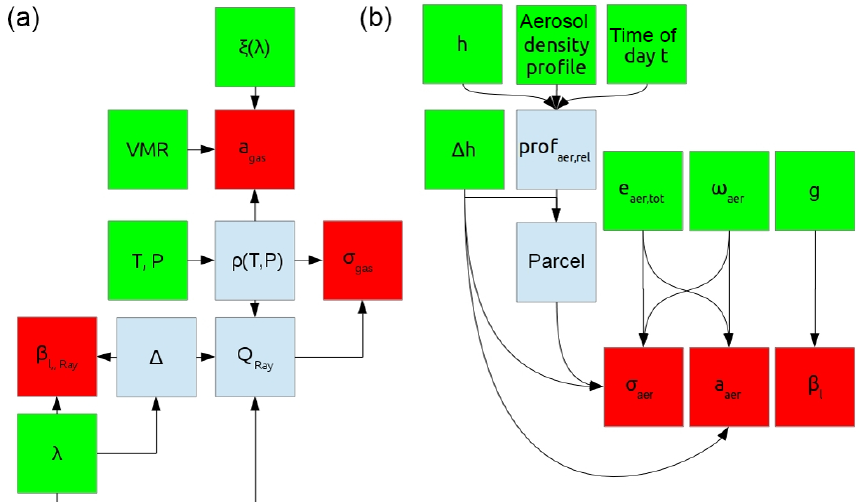
Figure 3. Calculating the gas and air (a) and aerosol (b) contributions to the layer input parameters for VLIDORT. The green boxes are primary input to MMF, blue boxes are intermediate quantities and red boxes are final outputs that are combined for VLIDORT layer input. Here VMR denotes the a priori volume mixing ratio. Instead of a VMR, an a priori trace gas density can be supplied,